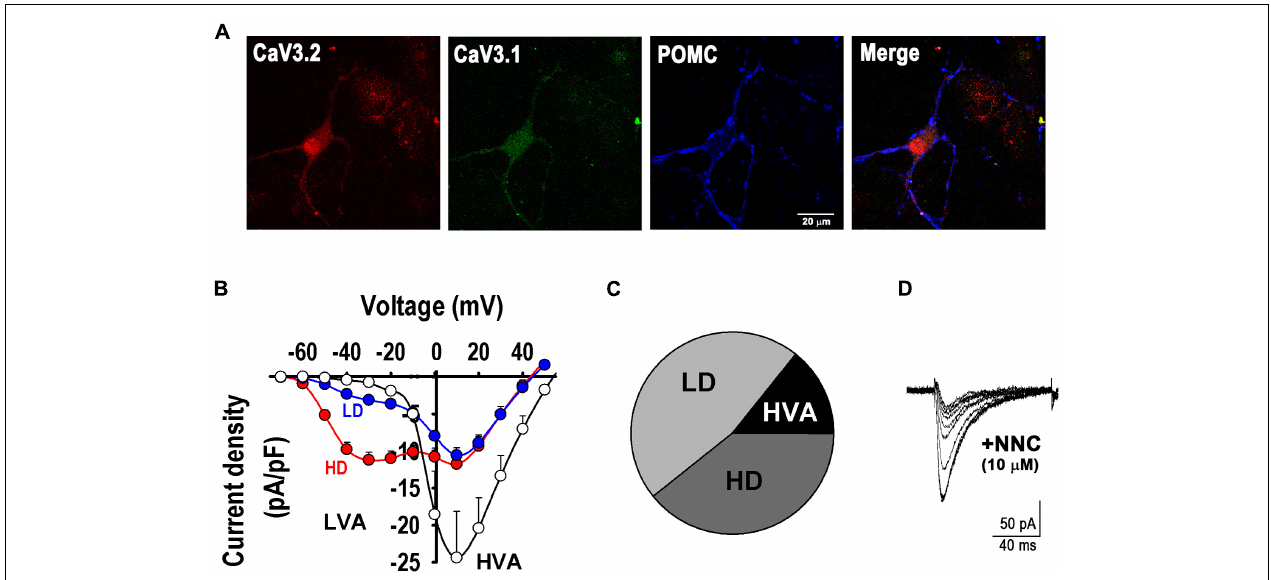
FIGURE 3 | T-type calcium channels in POMC neurons. (A) Example of fluorescence images showing the expression of T-type α 1 H (Ca V 3.2, red) and α 1 G (Ca V 3.1, green) channels in a POMC neuron (blue). Bar size, 20 µ m. (B) I-V curves depict three distinct neuron groups ( n = 28): empty circles, neurons expressing only high-voltage activated (HVA) currents; blue circles, neurons expressing low HVA and low LVA current density levels (LD, I LVApeak < 6 -pA/pF); and red circles, neurons expressing low HVA and high LVA current density (HD, I LVApeak from 6 to 20 -pA/pF). (C) Pie chart denotes the percentual number of neurons in each group described in (A) . (D) T-type calcium current blockade by its specific blocker NNC 55-0396 (10 µ M); the trace amplitude decrement sequence is shown every 2 min before (larger trace) and during application of the